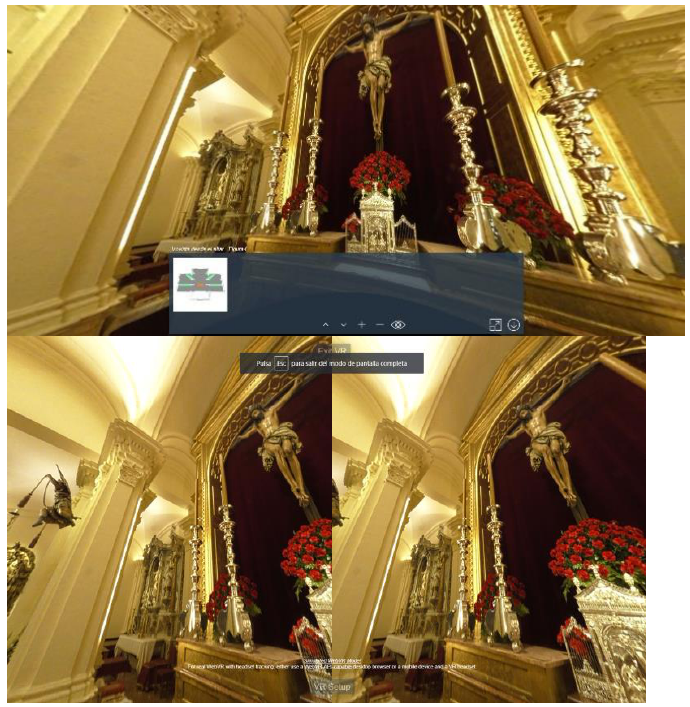
Figure 3. Isovists in 2D and 3D and real image of the chapel from that area. The material produced incorporates AR and VR objects (Figure 4).